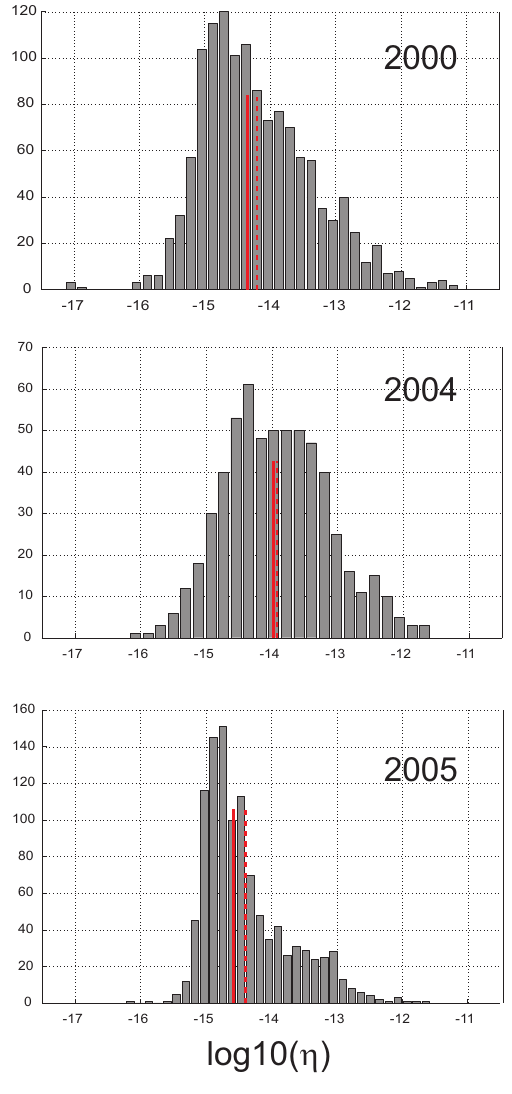
Fig. 5. A comparison of logarithmic histograms for the estimated PMSE backscatter cross-sections for the month of July in 2000 (up- per panel), 2004 (middle panel) and 2005 (lower panel). PMSE strengths at Resolute Bay were strong during these three years. The solid and dash-dash lines refer to the distribution median and geo- metric mean, respectively. The number of events is counted in every fifteen minutes interval. (In July 2004, the radar was operated only for ten days.)